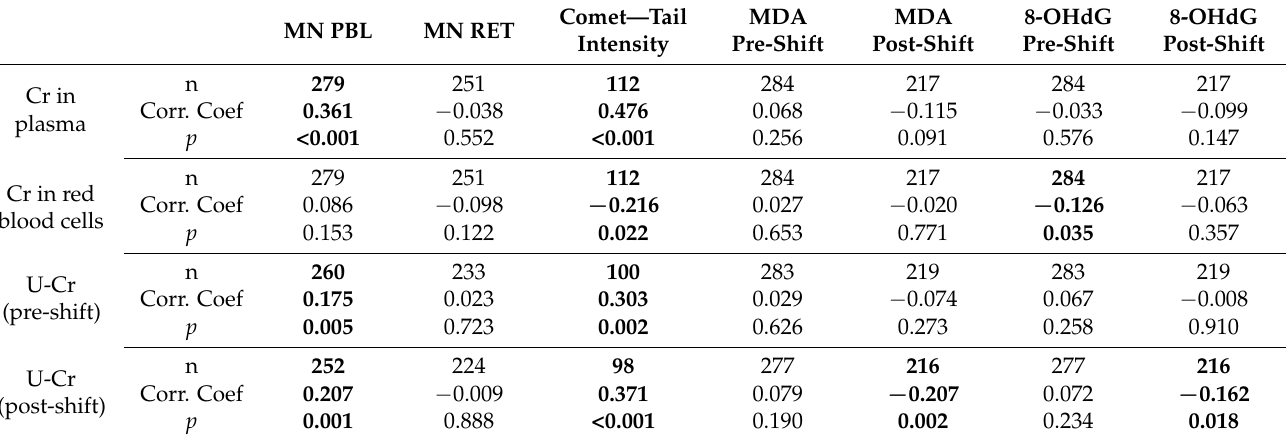
Table 4. Results of the correlation analysis between exposure and effect